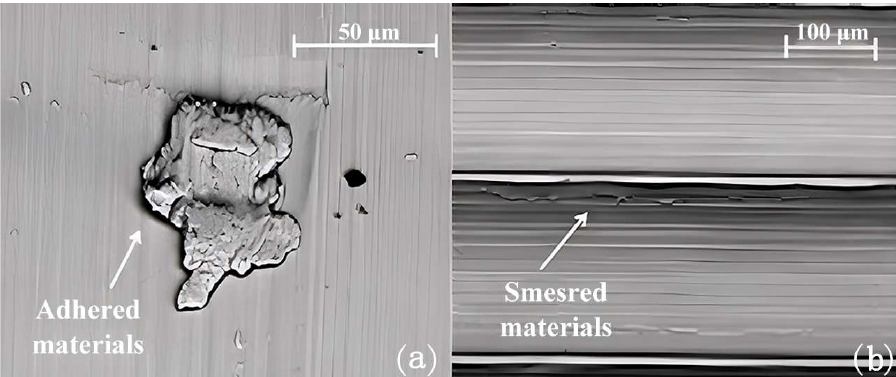
Figure 6. The surface defect generated during dry cutting: ( a ) adhered material and ( b ) smeared material [109] (Reprinted with permission from [109]. Copyright 2016, Elsevier).